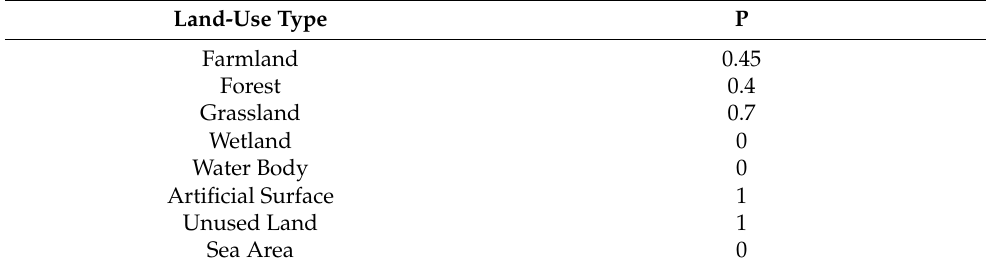
Table 3. Soil and water conservation measure factors (P). Land-Use Type P Farmland